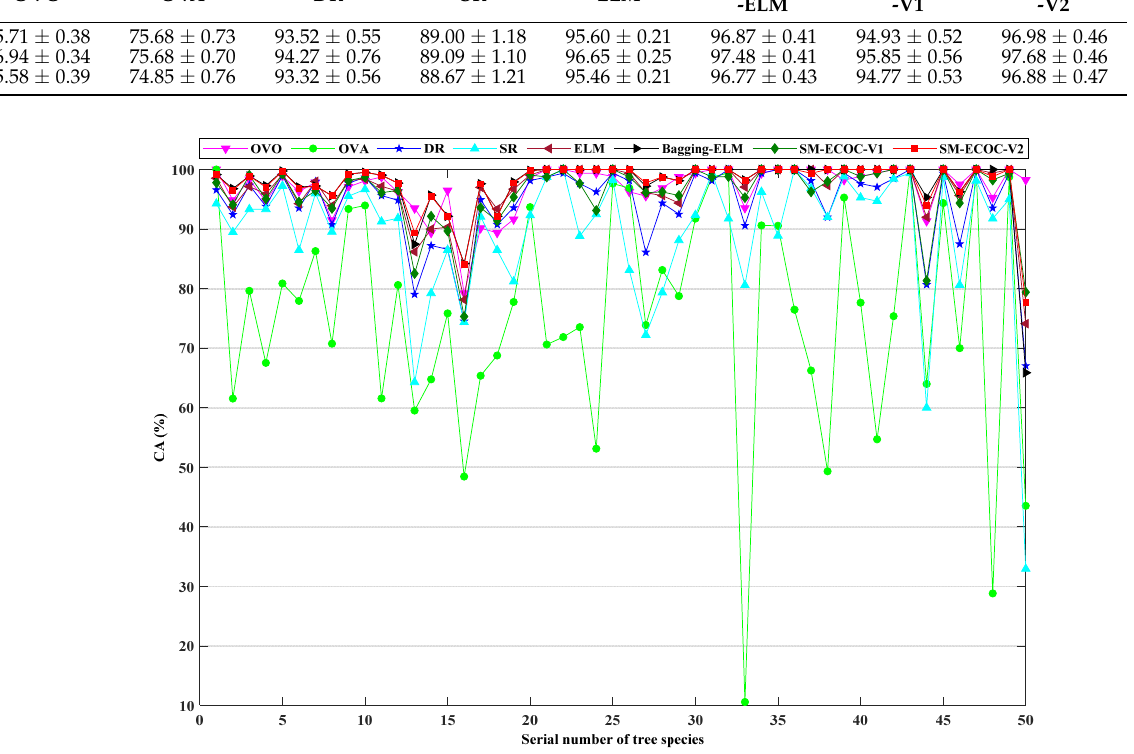
Figure 13. Class accuracy (%) of different classification models established based on all